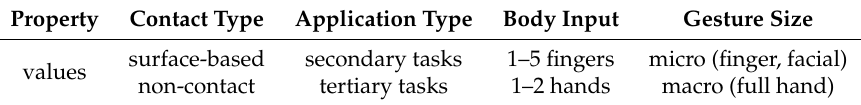
Table 1. Classification of in-car gestural interaction methods